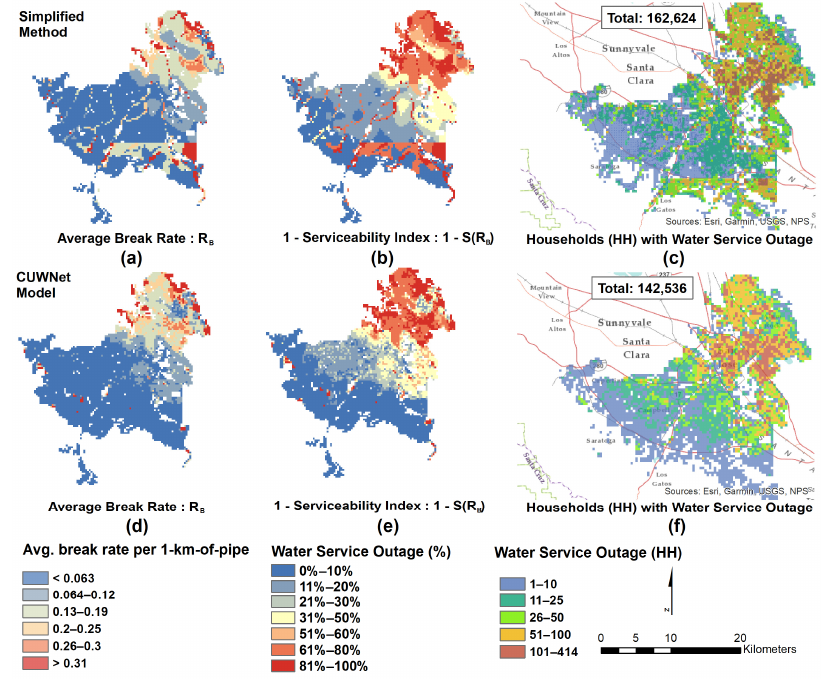
Figure 11. Comparison of simplified approach in SJWC service area with CUWNet model estimates: ( a ) Average break rates from simplified method; ( b ) water service outage (%) from simplified method; ( c ) water service outage (HH) from simplified method; ( d ) average break rates from CUWNet model [1] ( e ) water service outage (%) calculation from CUWNet model [1] break rates; ( f ) water service outage (HH) calculation from CUWNet model [1] break rates. Ground-motion intensities decrease and change less frequently over larger areas